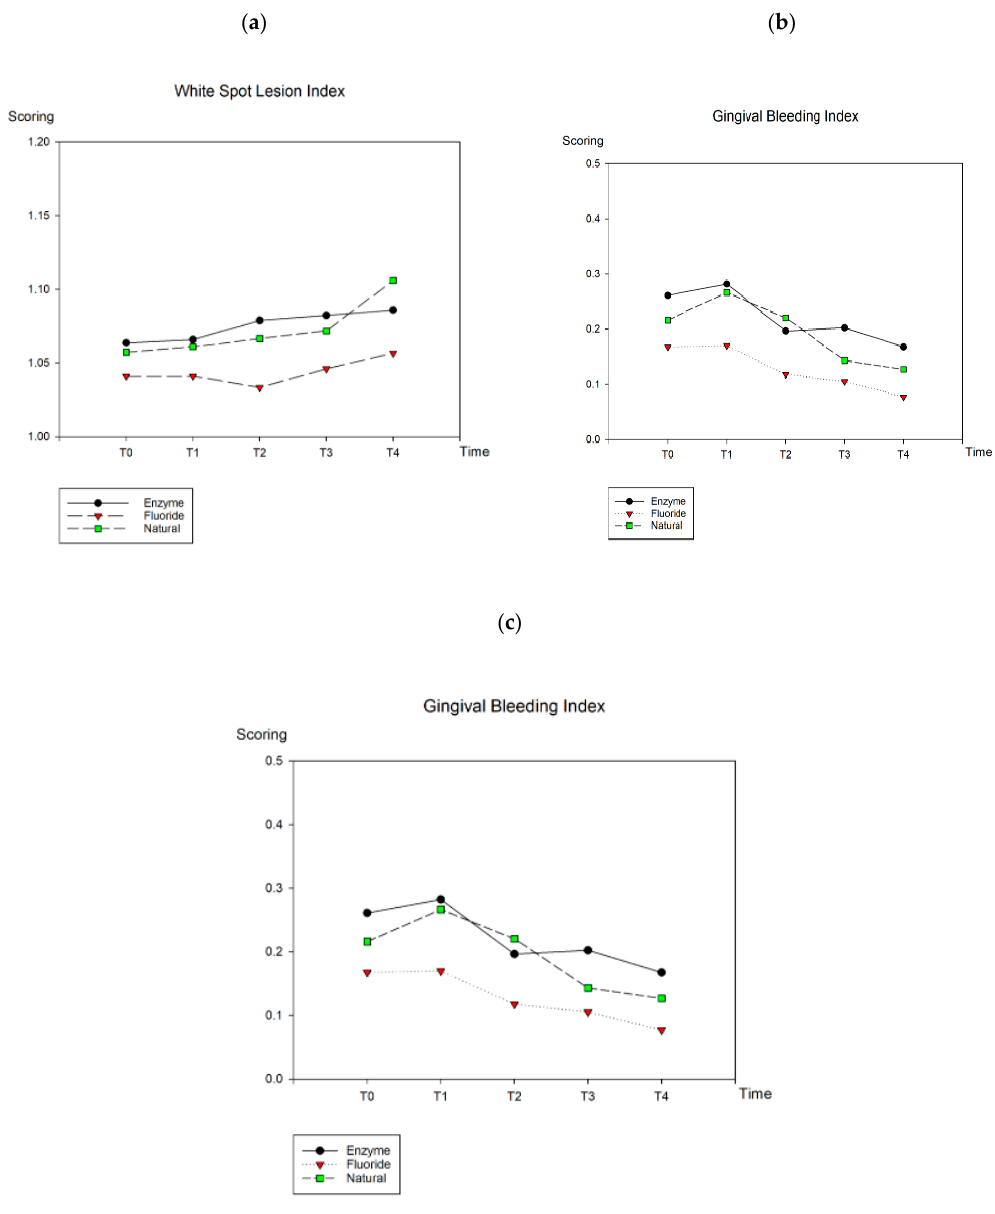
Figure 2. Comparisons of average scoring in three variables among the three dentifrices from T0 to T4: ( a ) WSL; ( b ) GBI; ( c ) VPI.